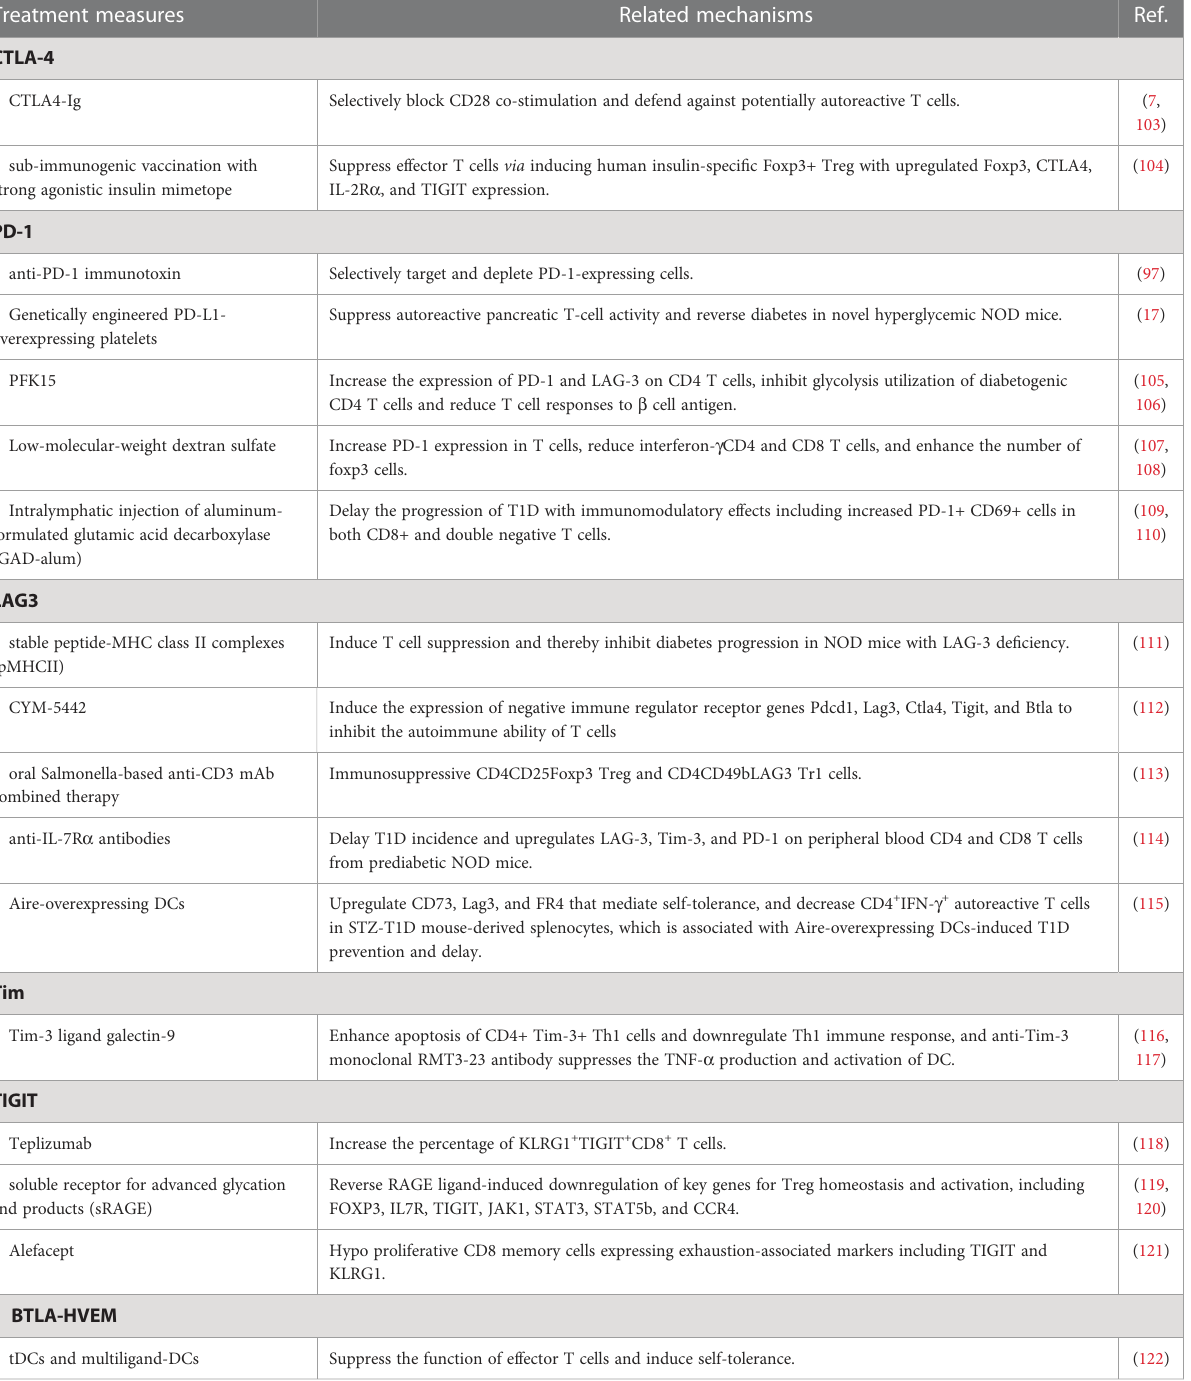
TABLE 1 The roles of treatment measures regulating co-inhibitory molecules for T1D. Treatment measures Related mechanisms